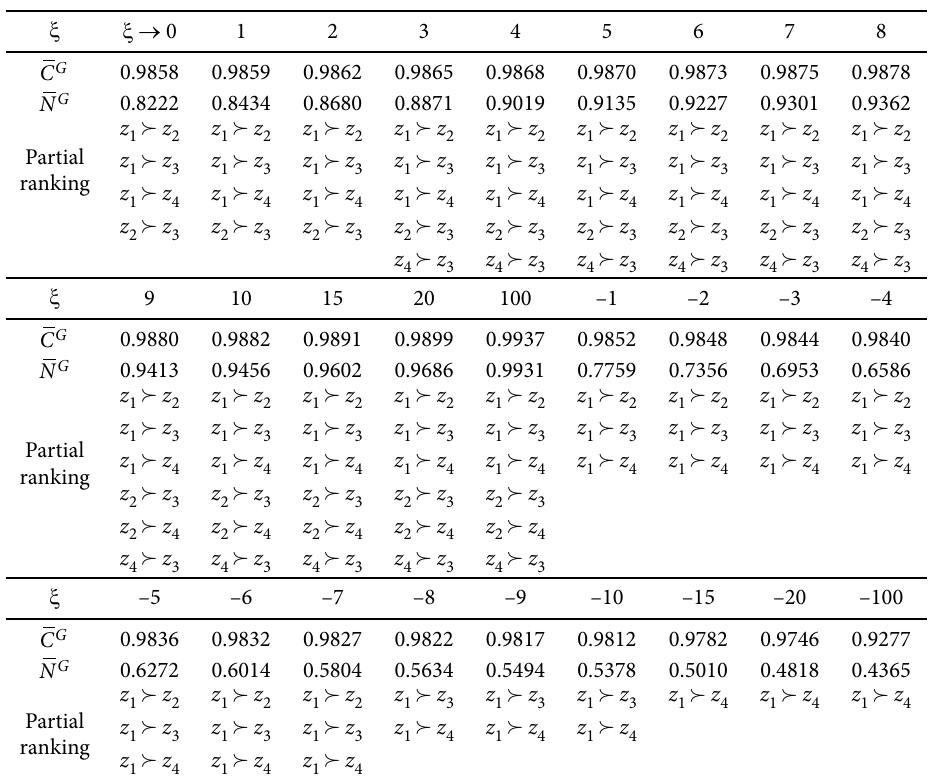
Table 8. A comparison of the solution results with distinct threshold